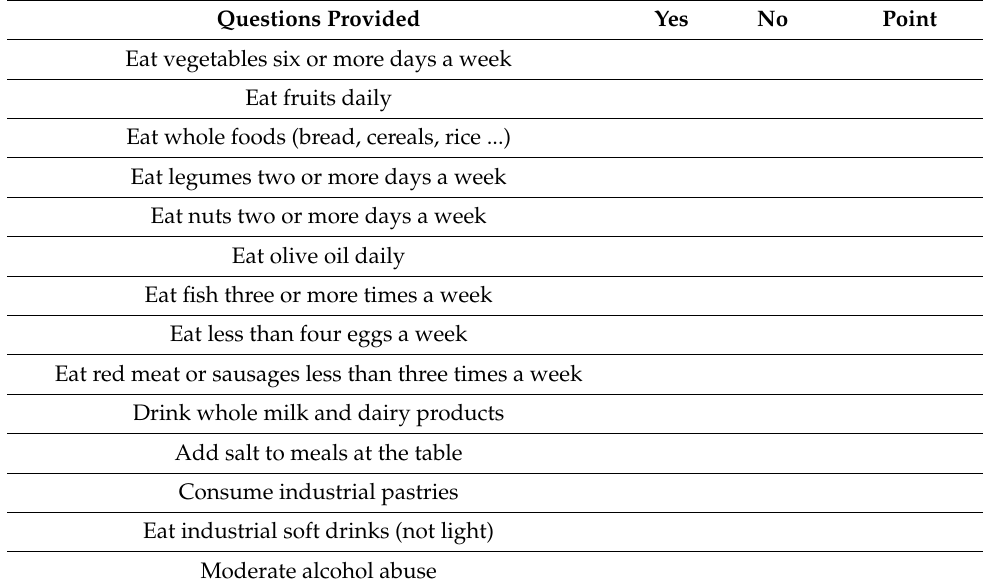
Table 2. Questionnaire provided to the patients. Adapted from Katsouyanni K et al. and Estruch R et al.